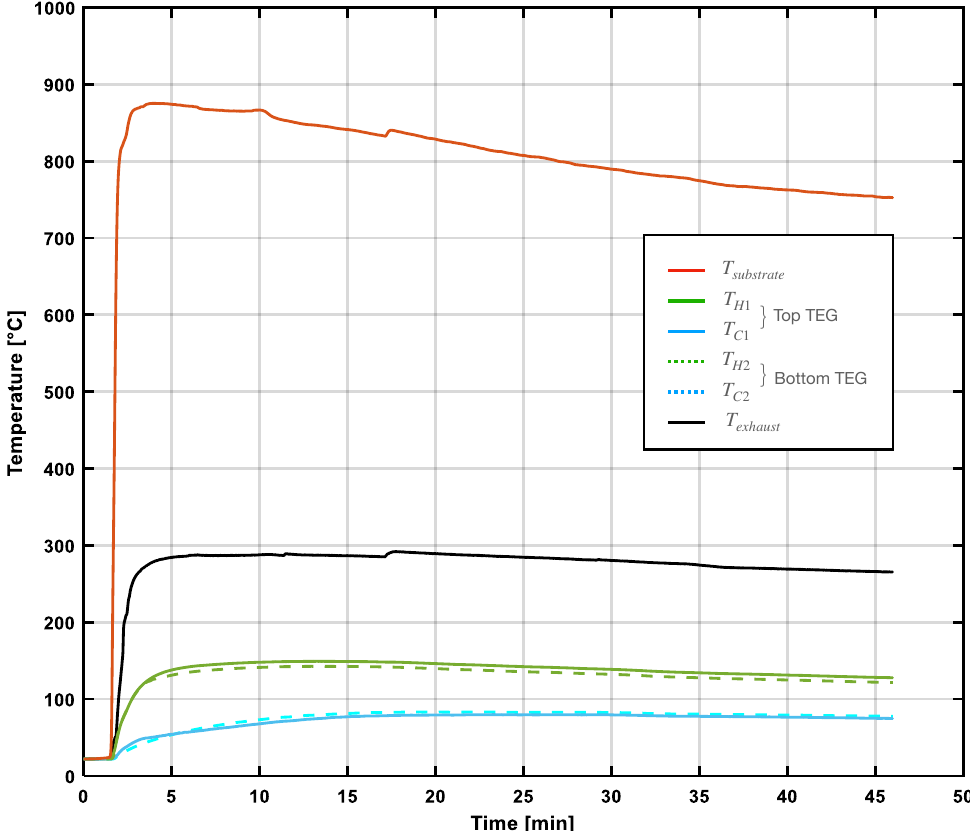
Figure 3. Temperature histories of microcombustion reactor facility without the thermal manage- ment modifications. The experiment was run at 6000 mL/min air flow rate with a 2SSC substrate. T substrate represents the temperature at the center of the substrate. T H and T C represent the hot and cold side temperatures, respectively, of the top and bottom TEG modules. T exhaust is the reactor exhaust